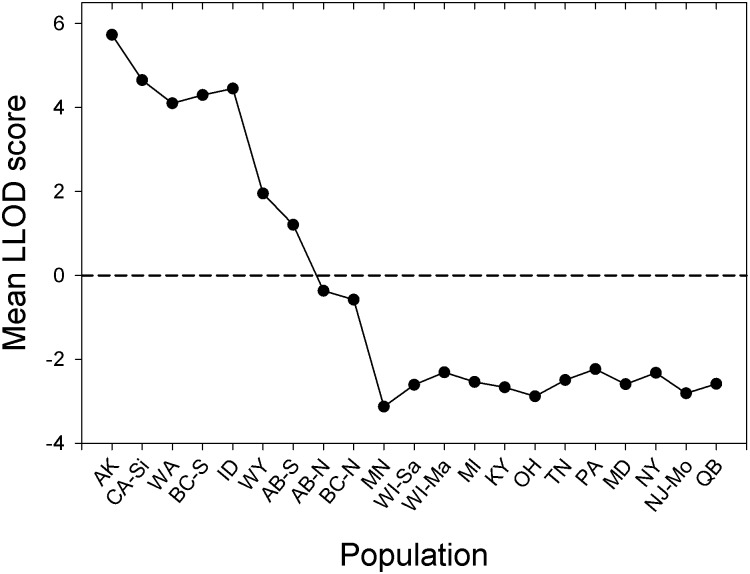
Mean log-likelihood difference (LLOD) between two genetic clusters obtained by FLOCK along a series of geographically ordered sites from west to east.For presentation, populations in the Great Plains-Rocky Mountains transition zone (BC-N AB-N, AB-S, and WY) are ordered by LLOD to demonstrate the transition among clusters.